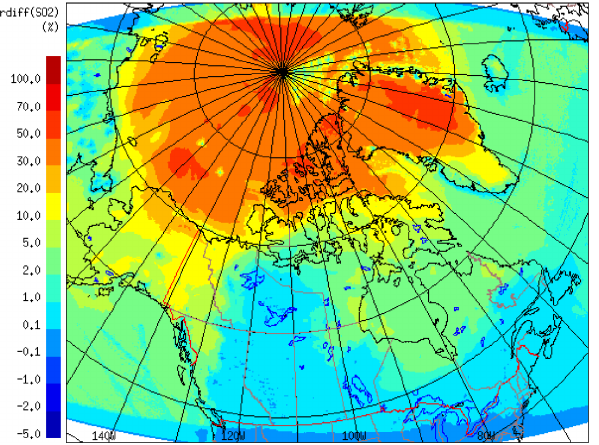
Figure 16. The relative percentage of the July 2014 averaged SO 2 with and without the 75% yield of SO 2